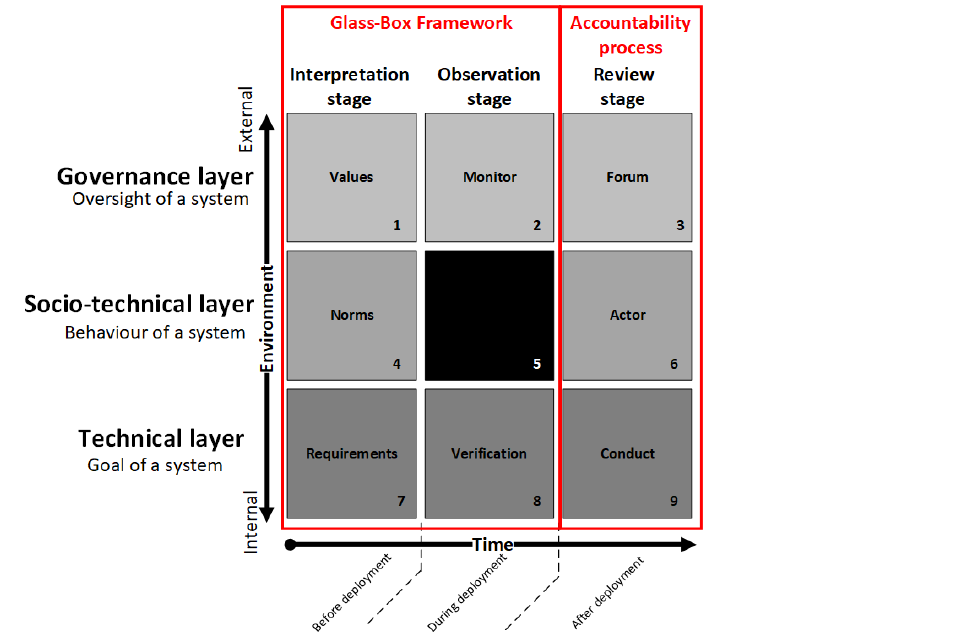
Figure 3. Glass Box framework projected on